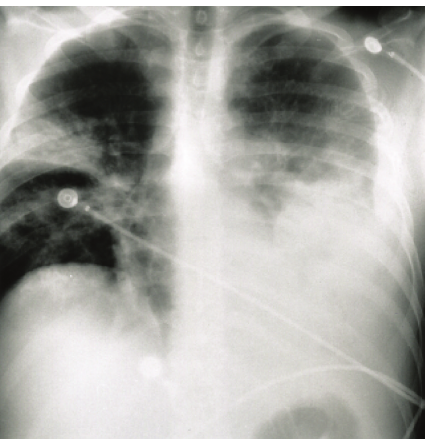
Figure 1: Chest X-ray on the 5th day.